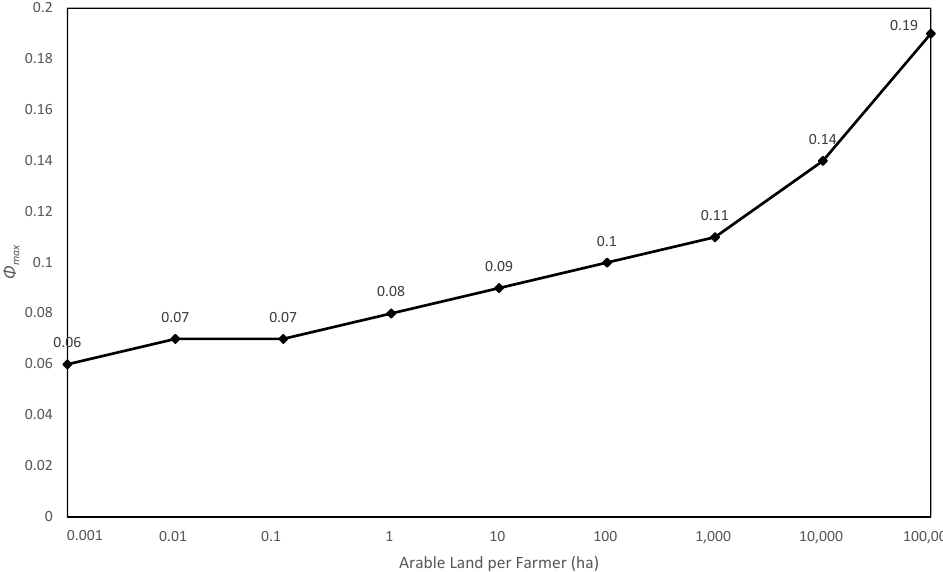
Figure 4. Relation of ALPF to maximum acceptable transaction cost index, Φ max